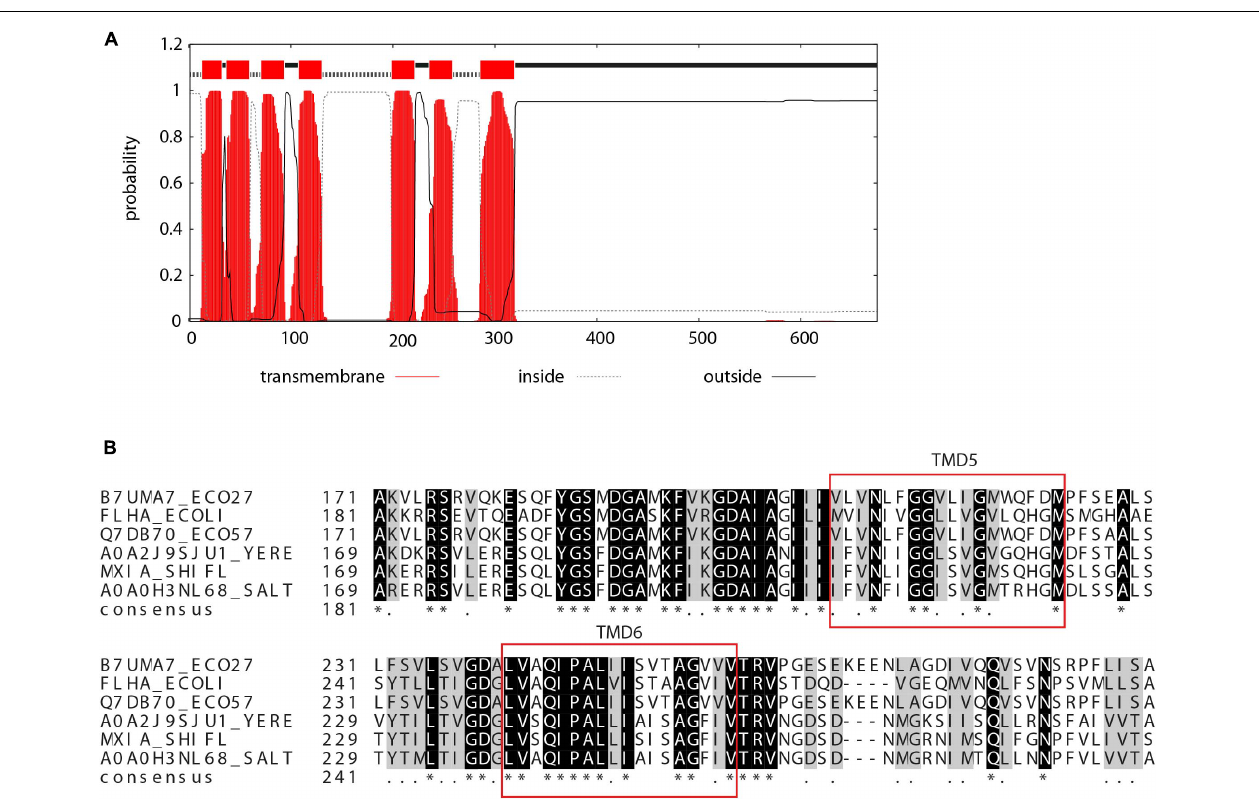
FIGURE 1 | Prediction of TMDs of EscV. (A) TMHMM software prediction analysis of the probability of each EscV amino acid to be localized within the bacterial membrane. Seven TMDs were identified (sequence is colored red). (B) Sequence alignment of the EscV export apparatus protein. A standard protein BLAST alignment is presented by ClustalW (Larkin et al., 2007) for EscV of EPEC T3SS (B7UMA7), FlhA of E. coli flagella (P76298), EscV of the E. coli O157:H7 (Q7DB70), YscV of the Y. enterocolitica (A0A2J9SJU1), MxiA of the Shigella T3SS (P0A1I5), and InvA of the S. typhimurium T3SS (A0A0H3NL68). A high level of conservation was observed within the TMD6 sequence and for the GxxxG motif found within